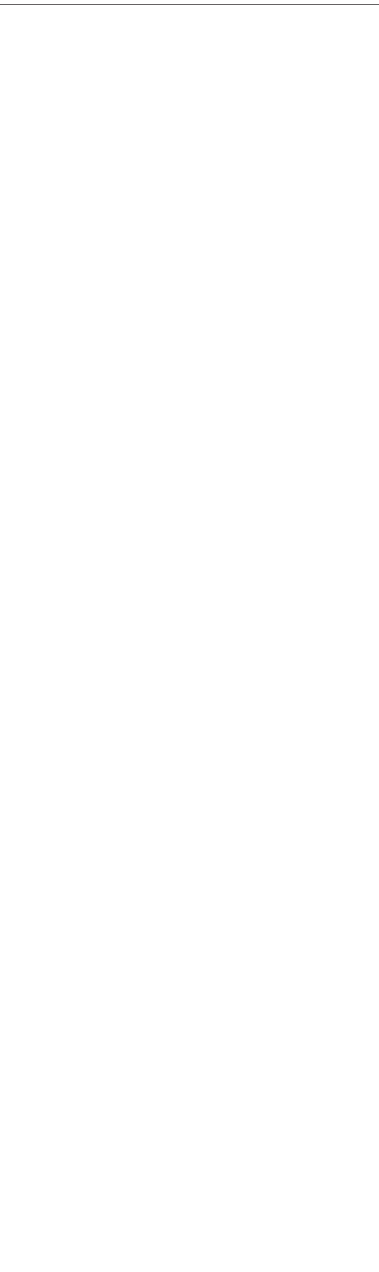
FIGURE 2 | C. trachomatis displays a CteG-dependent defect in egress from infected host cells. HeLa 229 cells were infected with C. trachomatis parental (L2/ 434), mutant ( cteG::aadA ), and complemented ( cteG::aadA harboring a plasmid encoding CteG-2HA; also named pCteG-2HA[Pgp4 + ] in Table 1 and in Figures 4 , 5 ) strains at an MOI of 0.06 for 48, 72 or 96 h. At each time post-infection (p.i.), cell supernatants were collected (supernatant fraction) and adherent cells were lysed by osmotic shock to recover intracellular chlamydiae (lysate fraction). Fresh layers of HeLa cells were infected with serial dilutions of both supernatant (A) and lysate (B) fractions to quantify the number of recoverable inclusion-forming units (IFUs/mL). Data correspond to the mean ± standard error of the mean (n ≥ 3). For each time point, statistical signi fi cance was determined by using ordinary one-way ANOVA and Dunnett post-test analysis relative to the L2/434 parental strain (ns, non-signi fi cant; *p<0.5; **p<0.01, ***p<0.001). For statistical analysis, natural logarithm was applied to data to ensure normality of the populations. (C) HeLa cells were left non-infected (N.I.), or were infected for 48 h with C. trachomatis L2/434, cteG::aadA or cteG::aadA harboring pCteG-2HA (also named pCteG-2HA[Pgp4 +